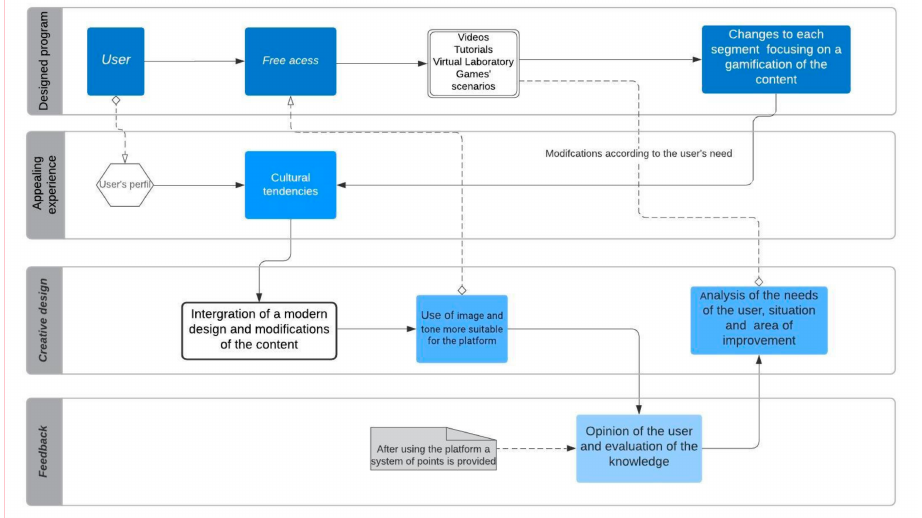
Figure 1. Example of a game in which the students need to locate the pathogens’ situation around the working environment. Note: the circle colored in red is the light cable where the pathogen is placed.